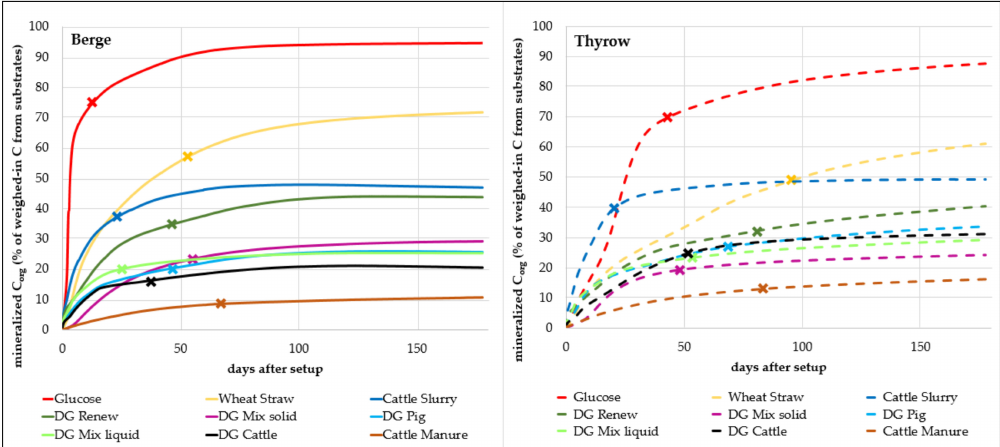
Figure 6. Mineralized proportion of the added organic carbon in the soil respiration experiment depending on the soil type. Soil from Berge with 7.8% clay, soil from Thyrow with 2.7% clay. Crosses mark the day on which 80% of the maximum mineralization was reached. Values shown are mean values from four repetitions.